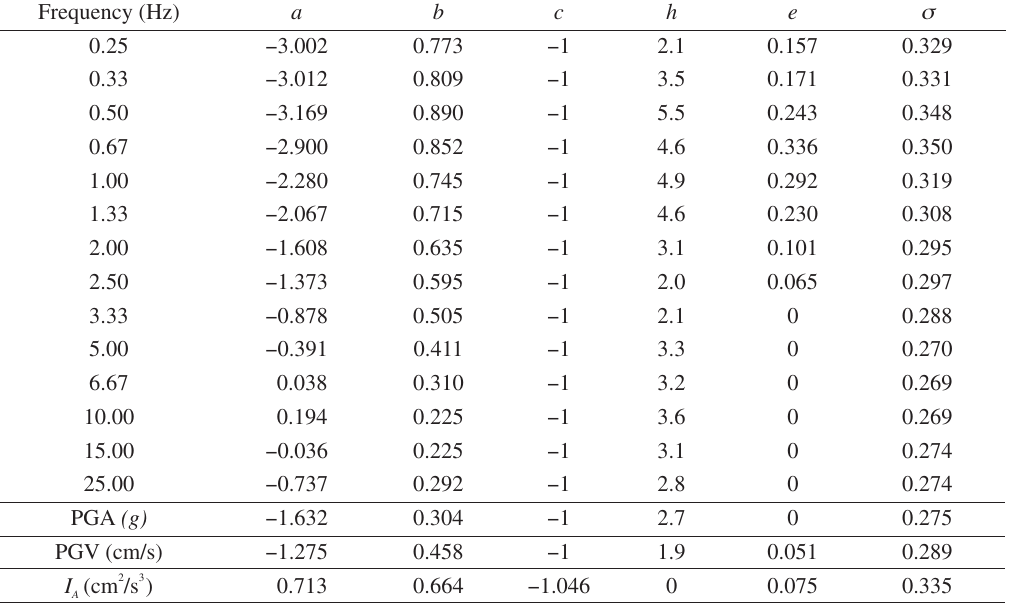
Table III. Regression coefficients for eq. (3.2) for Y equal to PSV, PGA, PGV or Arias Intensity. Coefficients are to be used for 4.5 (cid:41)